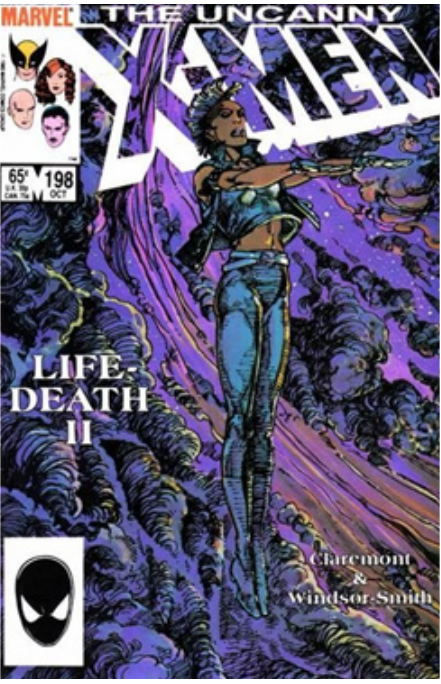
Figure 2. The Uncanny X-Men “Life-Death II,” Vol. 1, No. 198 (1985), cover by Barry Windsor-Smith.